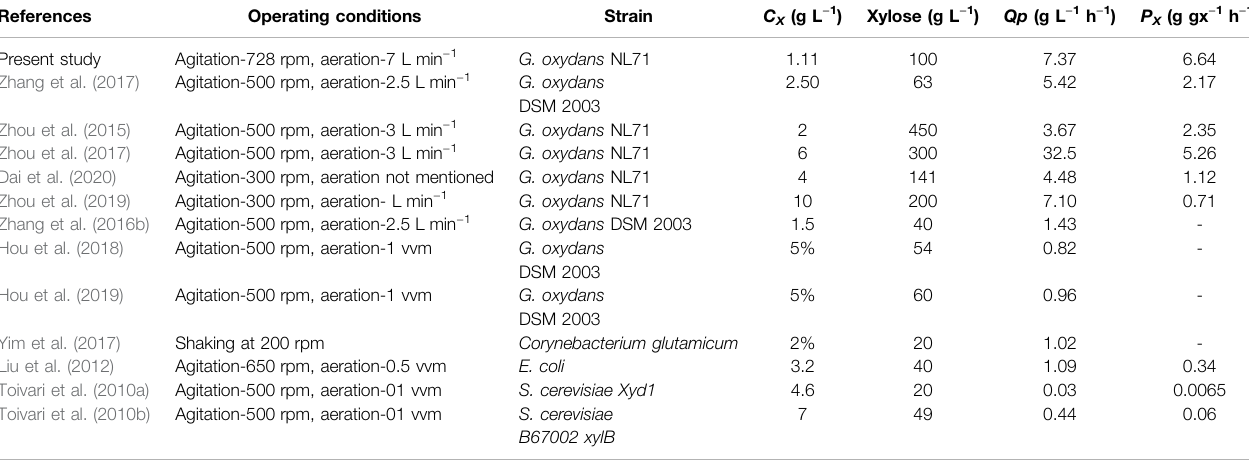
TABLE 5 | Comparative literature report on the production of XA under various process